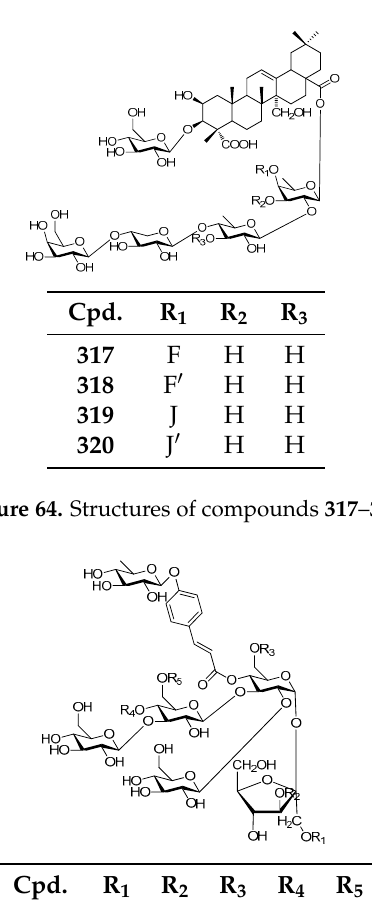
Figure 65. Structures of compounds 321 – 322 .